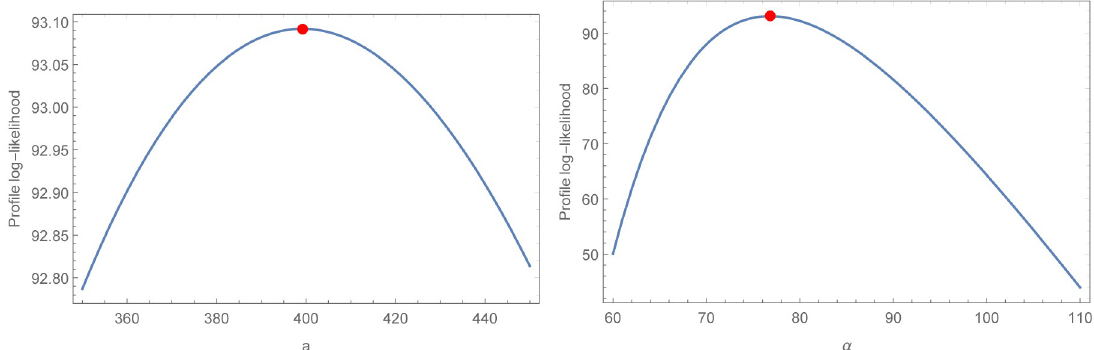
Fig 7. This figure discuses behavior of the log-likelihood function with a and α parameters of the first COVID-19 real data set. Which proves that the roots are global